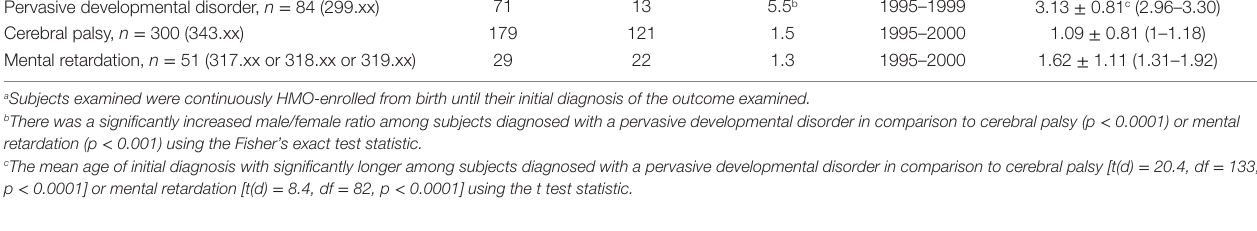
TaBle 2 | a summary of the various types of birth measurements examined among the outcomes studied. group examined a (icD-9 code) Pervasive developmental disorder, n = 84 (299.xx) Cerebral palsy, n = 300 (343.xx) xx or 318.xx or 319.xx)